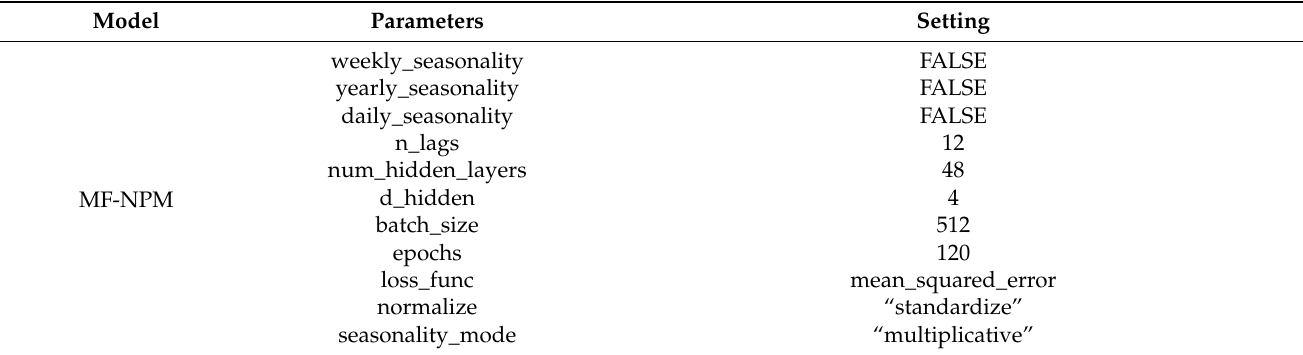
Table 2. The default settings are used for other relevant parameters in the MF-NPM. Table 2. Specific parameter settings of MF-NPM and LSTMNN